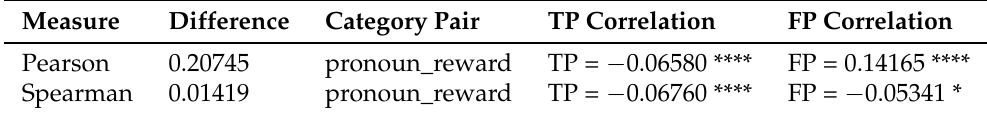
Table 47. Pronouns and Rewards in Suicidal.